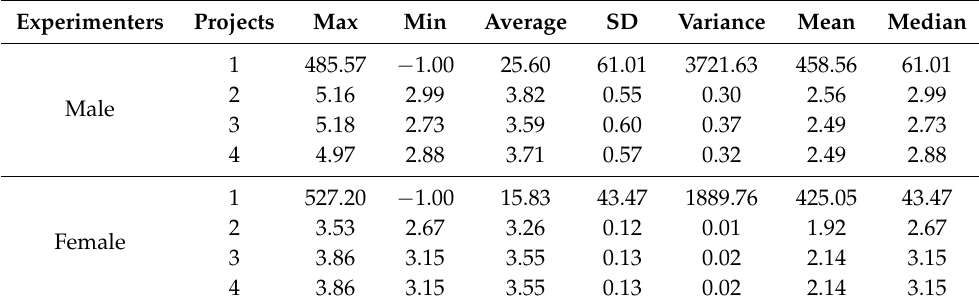
Table 2. Validation interface 1: Frequency domain analysis of male subjects’ eye movement data. Note: 1: eye-velocity processing data, 2: left-pupil processing data, 3: right-pupil processing data, 4: mean-pupil processing